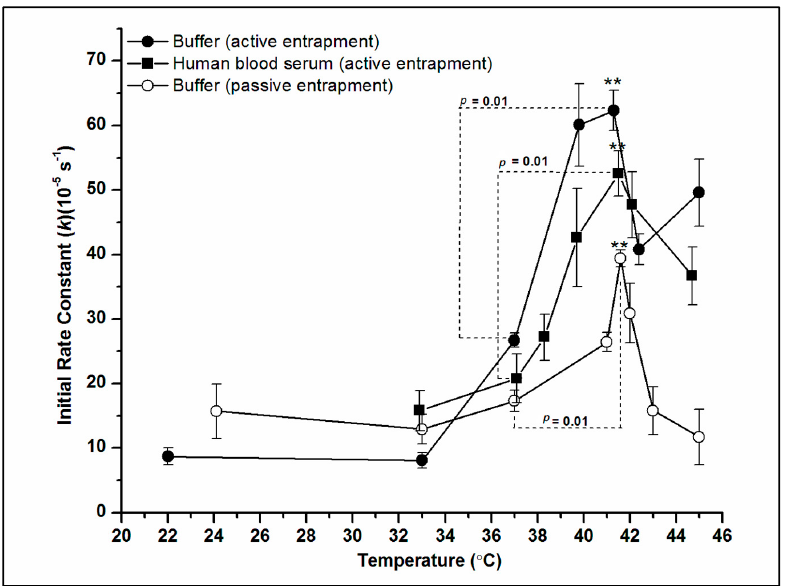
Figure 4. Effects of PLFE content and temperature on doxorubicin (DXO) release from liposomes. DPPC liposomal DXO samples containing 0, 20, and 30 mol% PLFE, with ~200 µM DXO entrapped, were prepared as described in Materials and Methods. The initial rate constant ( k ) was determined by following the enhancement of DXO fluorescence intensity due to spontaneous leakage over time at 24, 37, and 41–42 ◦ C. Liposomes (diameter ~160–200 nm) were dispersed in Tris-HCl bu ff er (pH 7.2). NS = not significant. Int. J. Mol. Sci. 2020 , 21 , x FOR PEER REVIEW